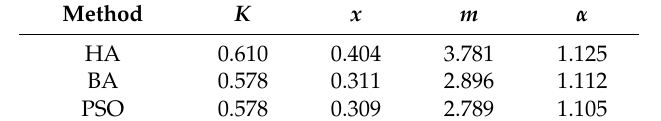
Table 12. The extracted coefficients for the four-parameter Muskingum model.